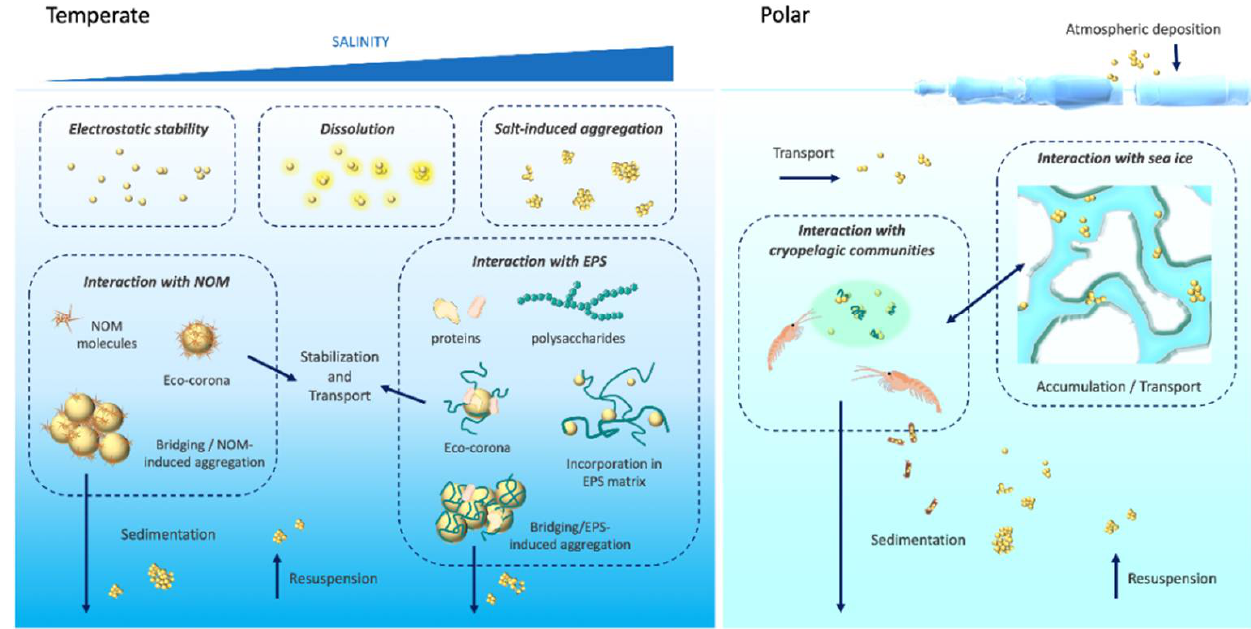
Figure 2. Schematic showing the processes regulating ENMs behavior, transport and fate in the marine environments from temperate ( left ) to polar ( right ) regions. Left: ENMs stability, dissolution, interaction with NOM and EPS and eco-corona formation are shown at increasing salinity. Right: ENM accumulation and transport in sea ice and interaction with cryopelagic communities are shown. Not to scale.